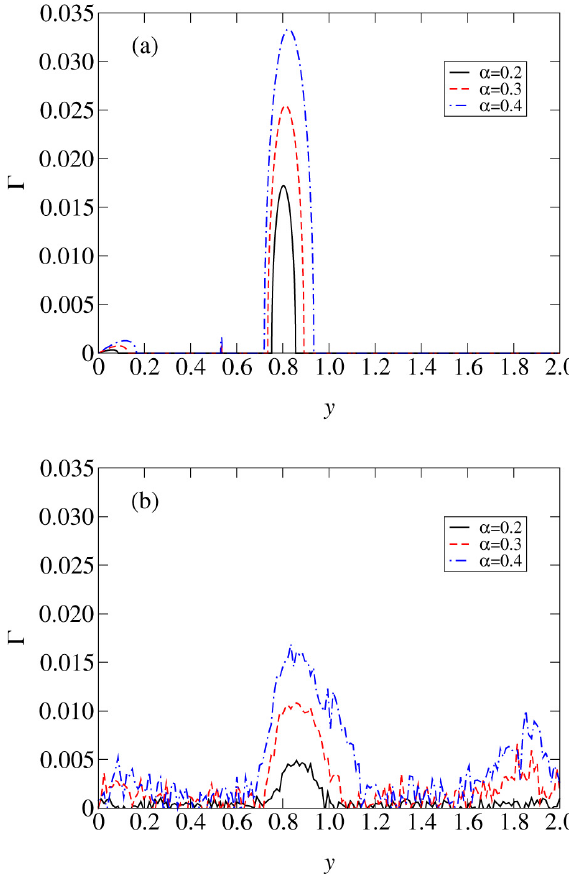
(a) Fluid result for the ( S + , p − ) crossing. (b) Simulation results for the same